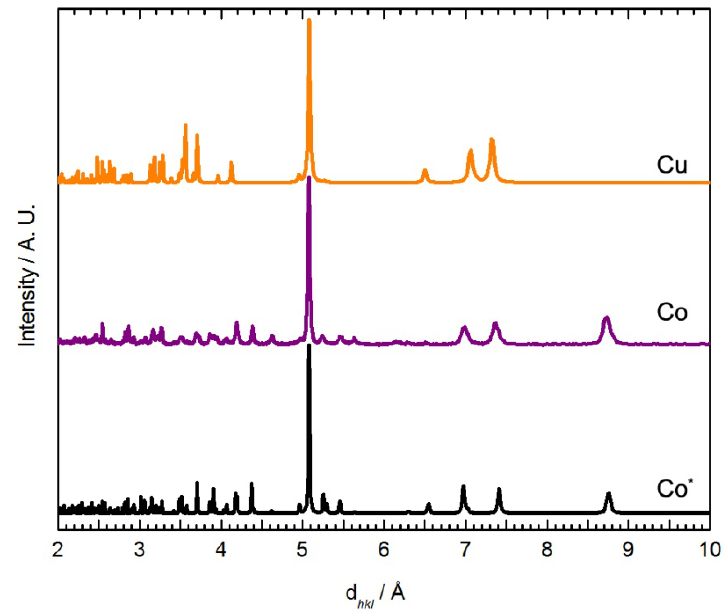
Figure 7. Comparison between the powder X-ray diffractogram (generated from single-crystal data) for Cu[Au(CN) diffractogram of Co[Au(CN) its structural model (Co*, black).